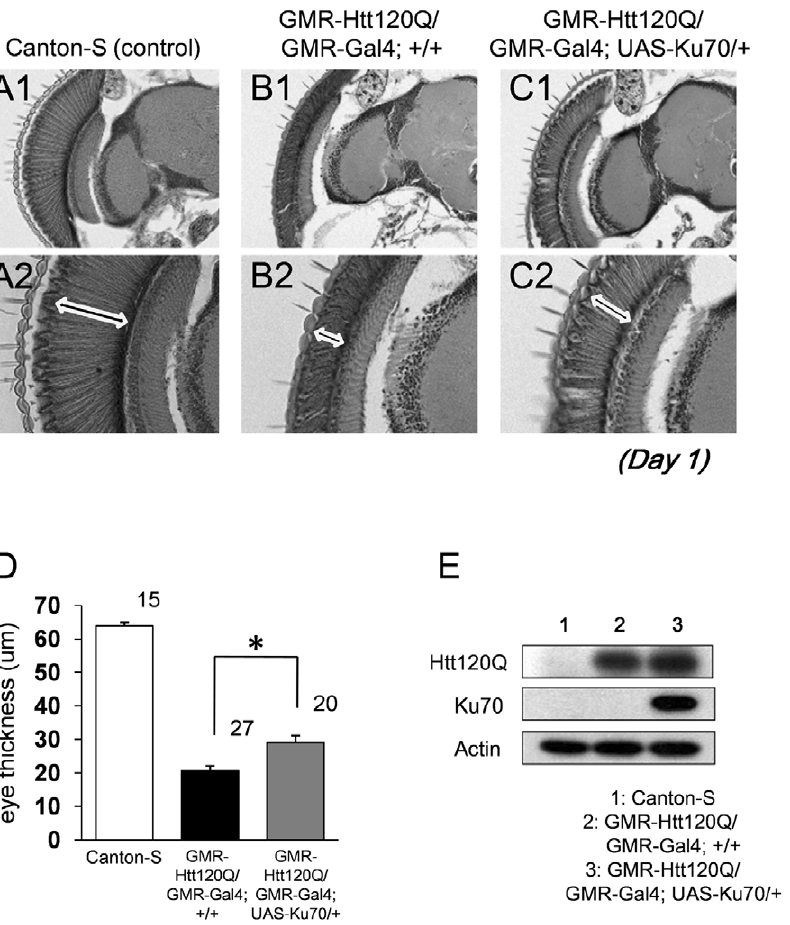
Figure 1. Ku70 reduces eye degeneration of mutant Htt in Drosophila models. (A-C) Axial sections of fly eyes from control Canton-S (A1 and A2), GMR-Htt120Q/ + ; GMR-Gal4/ + (Htt/ + ; B1 and B2) and GMR-Htt120Q/ + ; GMR-Gal4/UAS-mouse Ku70 (Htt/ + ;Ku70/ + ; C1 and C2) are shown at a low power (Upper panel) or a high power (Lower panel) magnification. White arrows indicate the retina thickness of each transgenic fly. In triple transgenic flies, co-expression of Ku70 partially repressed eye degeneration. Scale bar, 50 m m. (D) Quantitative analysis of the eye thickness of each transgenic fly. The number of counted flies was indicated above each bar. Mean + / 2 SE. *: p , 0.01, Student’s t -test. (E) Western blot analysis of the expression of mutant Htt (Htt120Q) and mouse Ku70 (Ku70) in fly eye. All flies tested were female. The genetic background was w (CS10) in this figure.